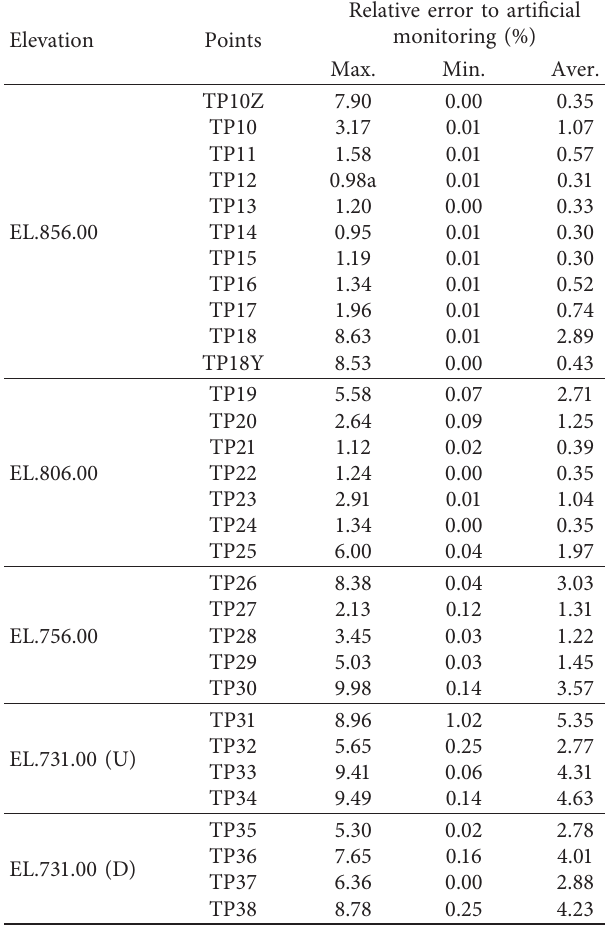
Table 2: Relative error between the TPS data and artificial mon- itoring